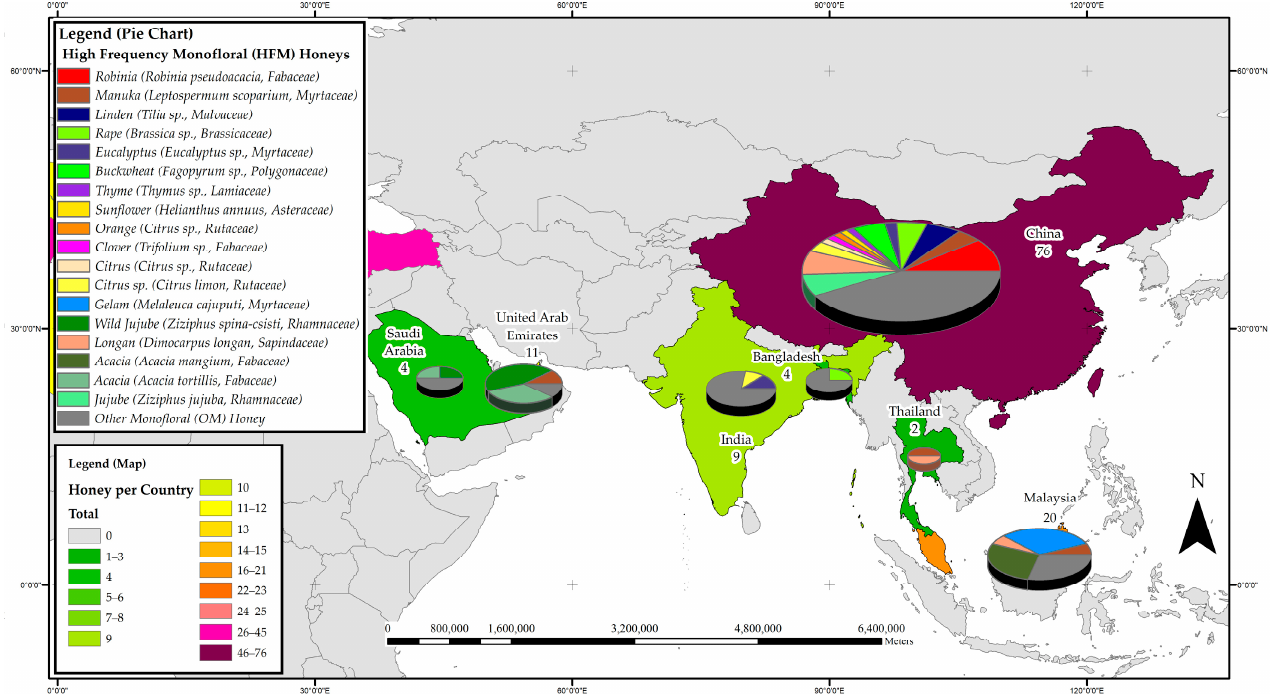
Figure 3. Most frequently studied honeys with respect to their phenolic profile in Asia.